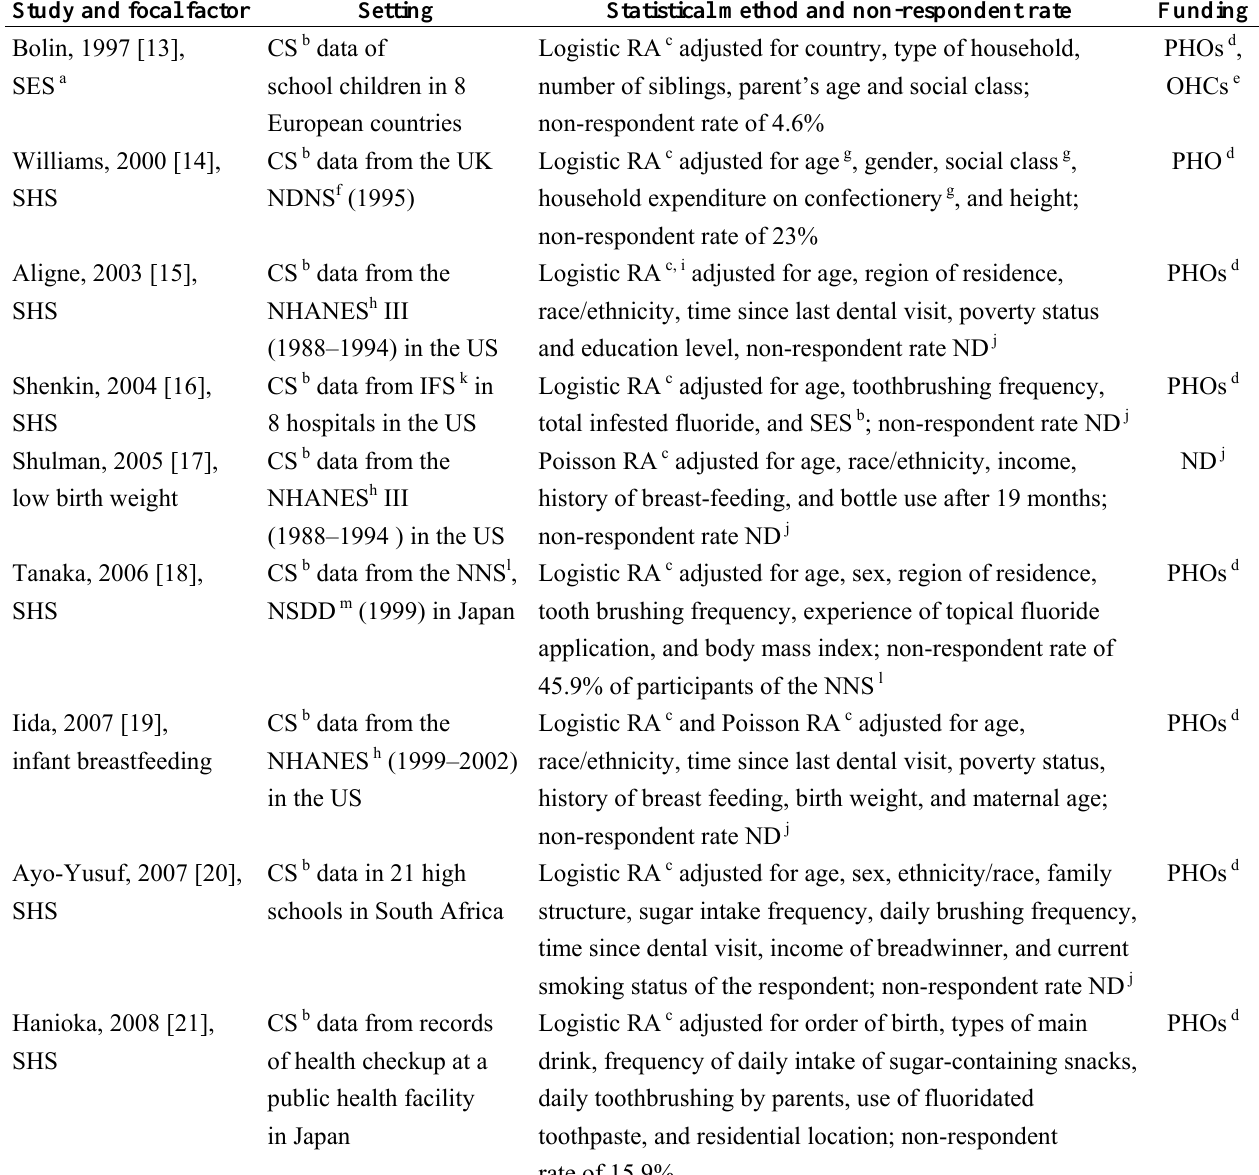
Table 1. Characteristics of the included